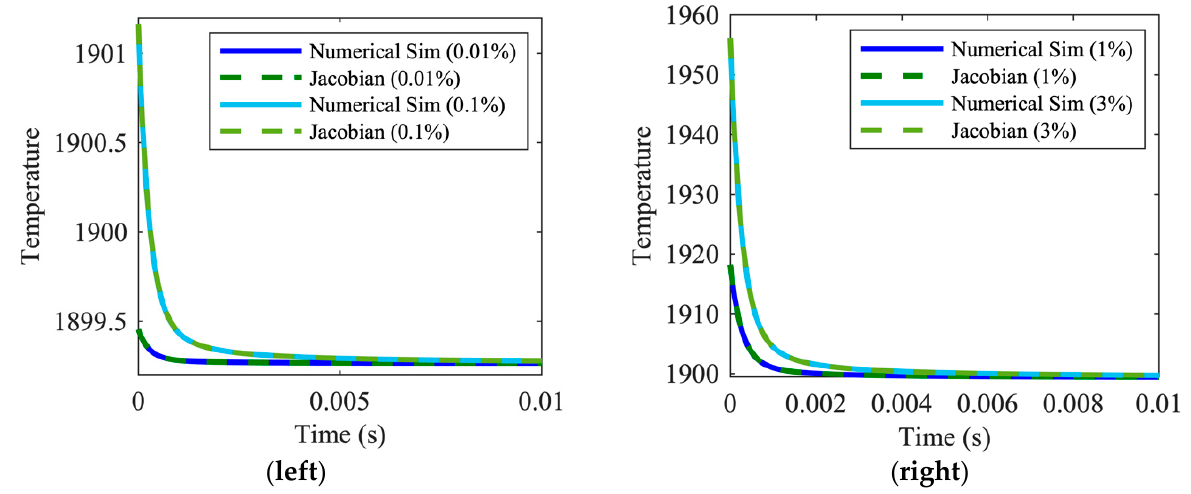
Figure 2. Temperature evolution at the point of perturbation. Perturbations of 0.01 and 0.01% of the original temperature (left). Perturbations of 1.0 and 3% of the original temperature (right).